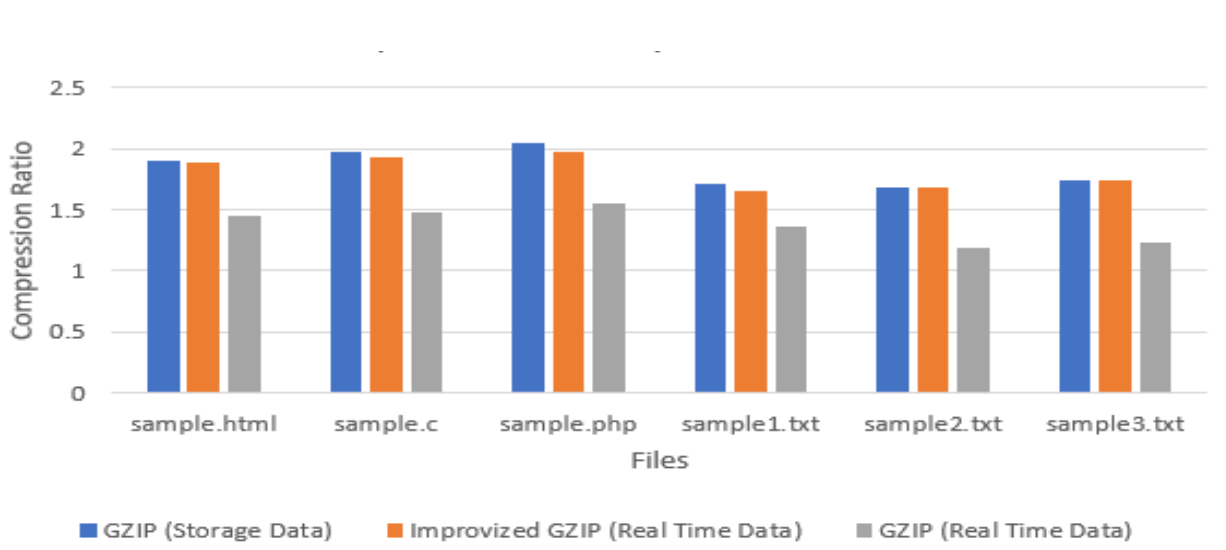
Figure 9. Comparisons of Space